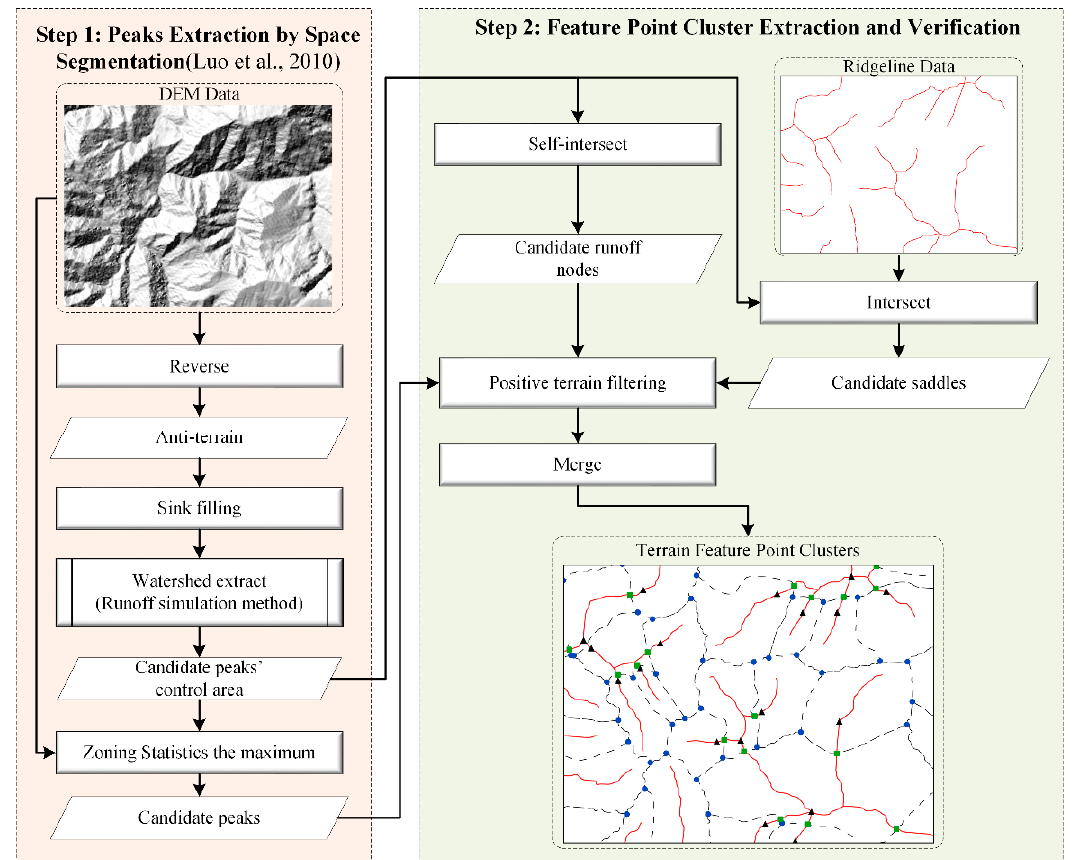
Figure 4. Processes of the terrain feature-point cluster extraction [33].